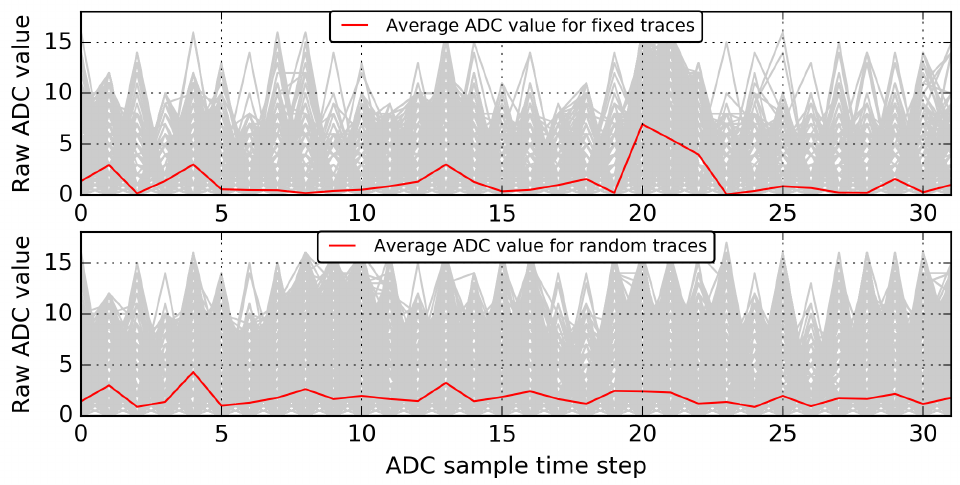
Figure 7: Average over 1M traces for a fixed message encrypted with mbedTLS AES and the FIPS key, and 1M traces with each a random message encrypted with the same key on the STM32F407VG Discovery #1. ADC connected to